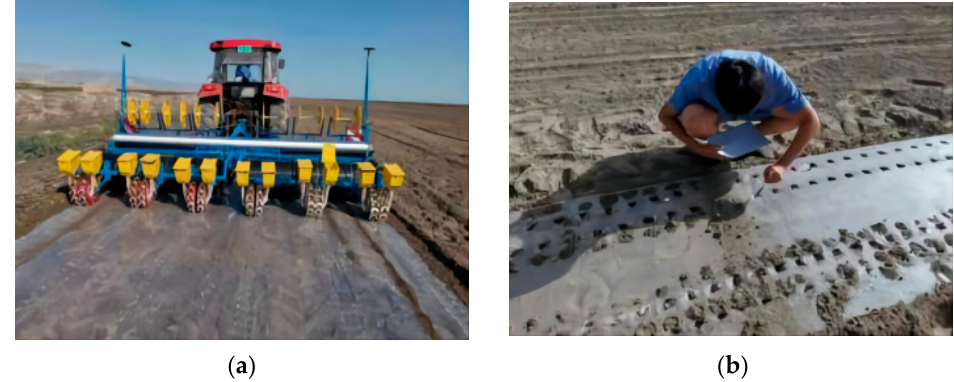
Figure 7. Field sowing monitoring test site: ( a ) prototype field test and ( b ) artificial counting.